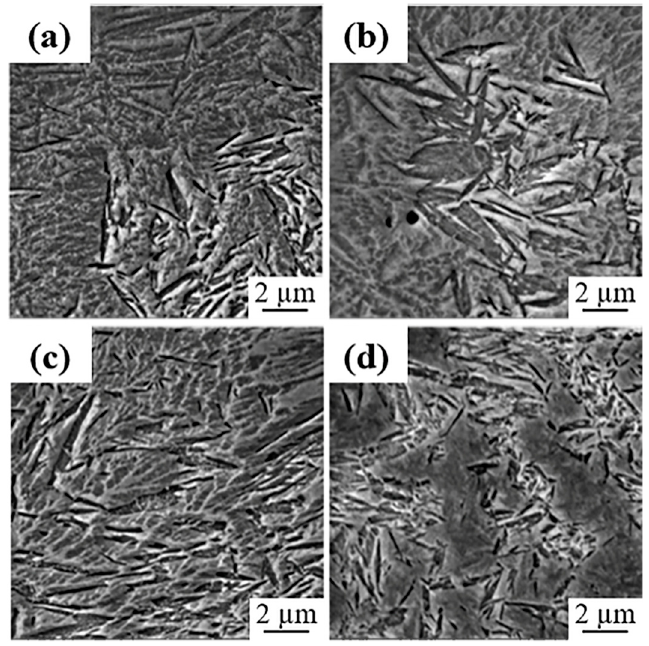
Figure 11. Microstructure of the HAZ (H2) to 70 W (P4), ( a ) Sample 1, ( b ) Sample 2, ( c ) Sample 3, ( d ) Sample 4.